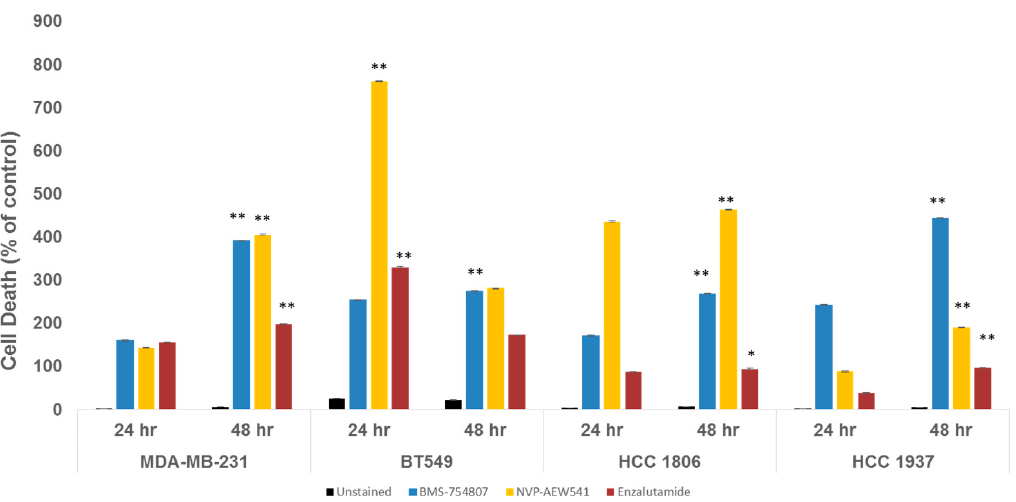
Figure 5. TNBC cell death is promoted by IGF1R/IR and AR antagonists. Results show % cell death of vehicle-treated controls. An independent control was used for each cell line. TNBC cells were exposed to either BMS-754807 (20 μ M), NVP-AEW541 (8 μ M) or enzalutamide (20 μ M) ( n = 3 independent experiments). Error bars represent standard deviation (SD). Data was analyzed by Prism GraphPad software using an unpaired Student t -test. p -Value < 0.05 are considered significant. ** p ≤ 0.005; * p ≤ 0.05.